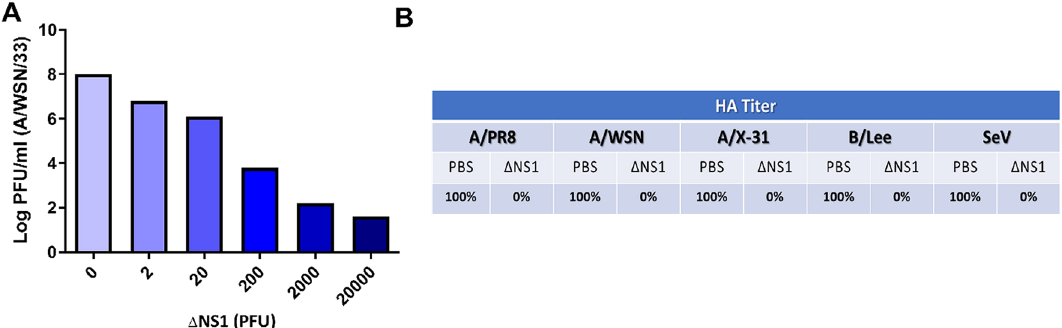
Figure 1. Pre-incubation with ΔNS1 virus inhibits viral replication in embryonated chicken eggs. ( A ) 10-day- old embryonated chicken eggs (n = 2 per group) were inoculated with varying amounts of (PFU) of ΔNS1 virus in the allantoic cavity. Eight hours post infection at 37 °C, eggs were re-infected with 10 4 PFU of WT A/ WSN/33 influenza virus and incubated at 37 °C for 40 h. Allantoic fluids were then titrated by plaque assay MDBK cells. ( B ) 10-day-old embryonated chicken eggs (n = 2 per group) were inoculated with 2 × 10 4 PFU of ΔNS1 virus or PBS (Untreated). 8 h post inoculation at 37 °C, the eggs were re-infected with 10 3 PFU of A/ WSN/33 (WSN/H1N1), A/PR/8 (PR8/H1N1), A/X-31 (X-31/H3N2), B/Lee/40 (B-Lee influenza B) or Sendai Virus (Sendai). B-Lee infected eggs were incubated at 35 °C for additional 40 h. All other eggs were incubated at 37 °C for additional 40 h. Virus present in the allantoic fluid was titrated by hemagglutination assays. Maximum hemagglutination titers (100%) for each individual virus were 2048 (PR8), 1024 (X-31), 256 (B-Lee), 512